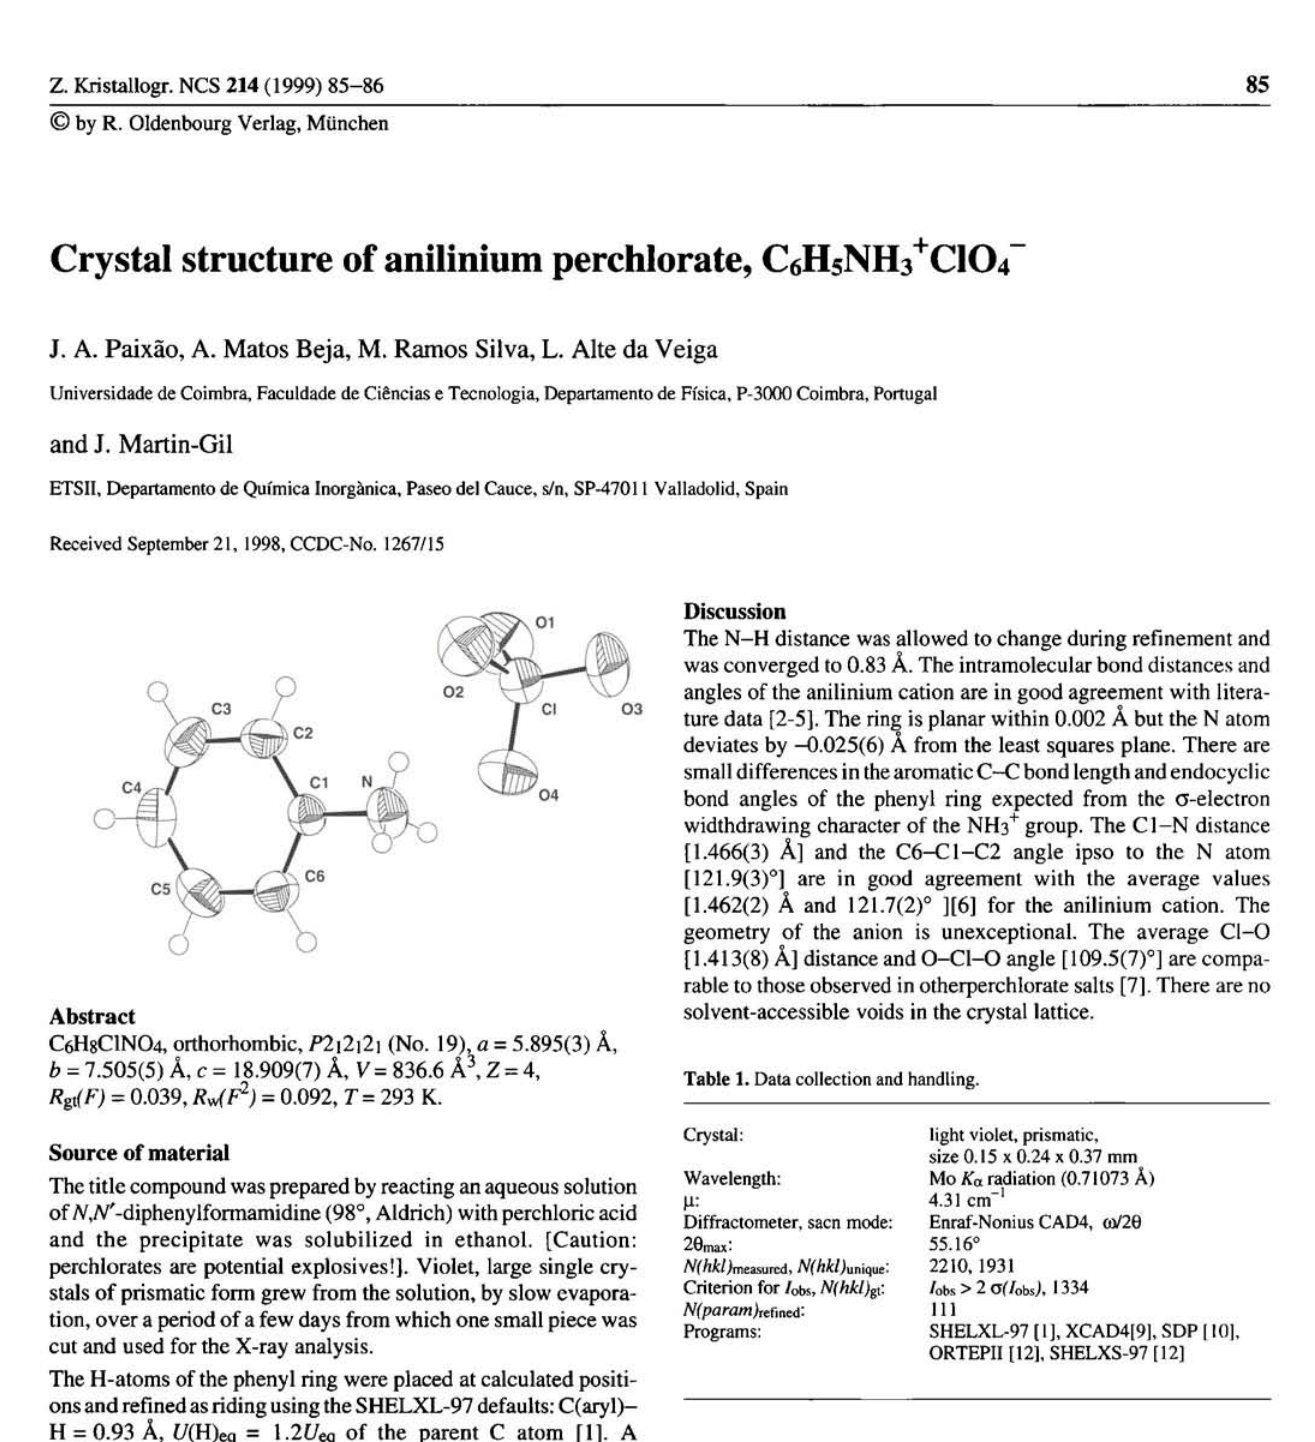
Table 2. Atomic coordinates and displacement parameters (in Λ